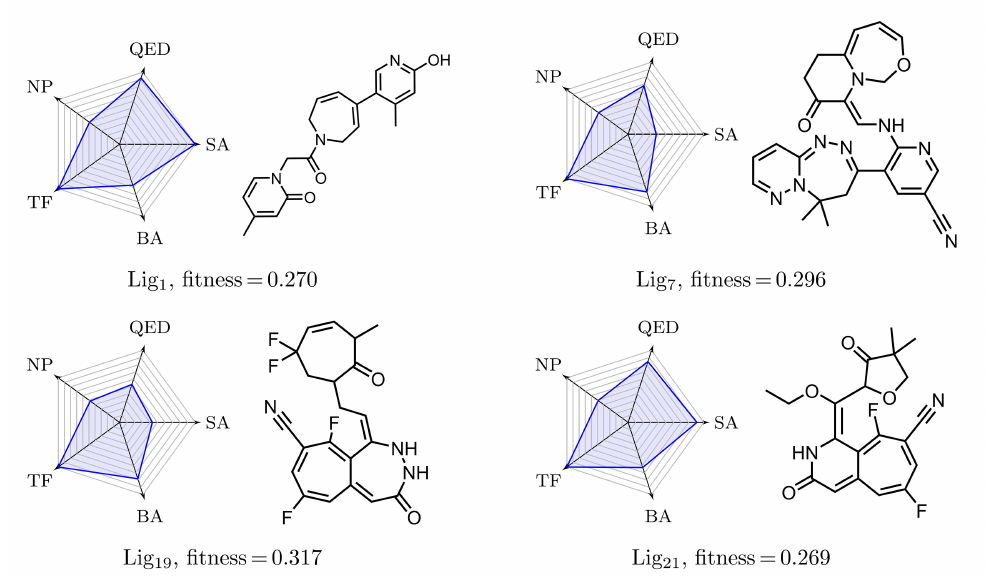
Figure 7. Molecular structures of four molecules, created by EMGA , with a high fitness score. Radar plots show how well the molecules perform with respect to the five metrics. The best scores are on the edge of the radar plot and the worst scores are in the